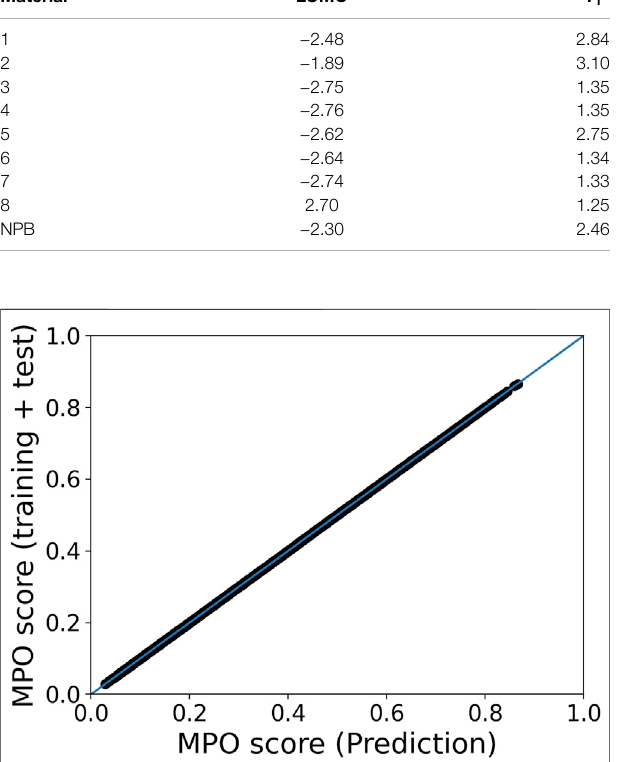
TABLE 1 | Calculated LUMO and triplet state energy (T 1 ) for some ofthe materials shown in Figure 3 and NPB. All energies are given in eV. Material